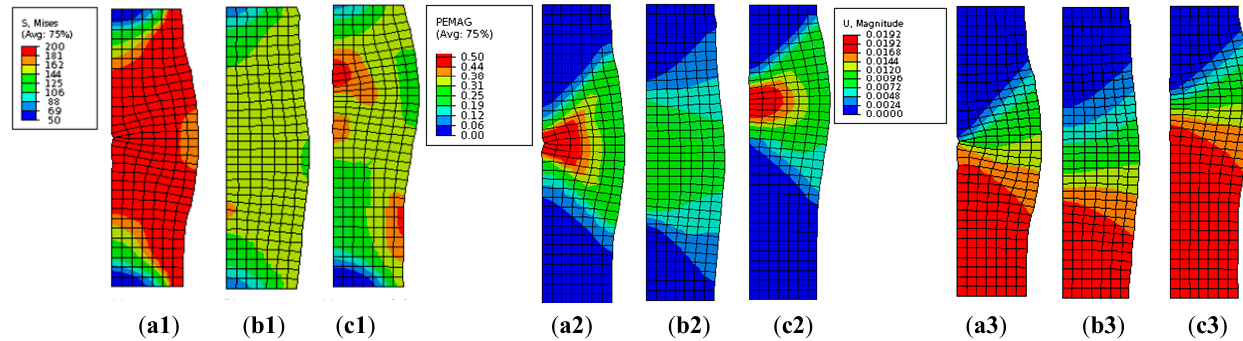
Figure 16. Contours of model cases at the 12% of axial strain representing the critical state of models ( a ) dense ( b ) loose and ( c ) layered_het_transition for Stress ( 1 ), plastic strain ( 2 ), and total displacement ( 3 ).